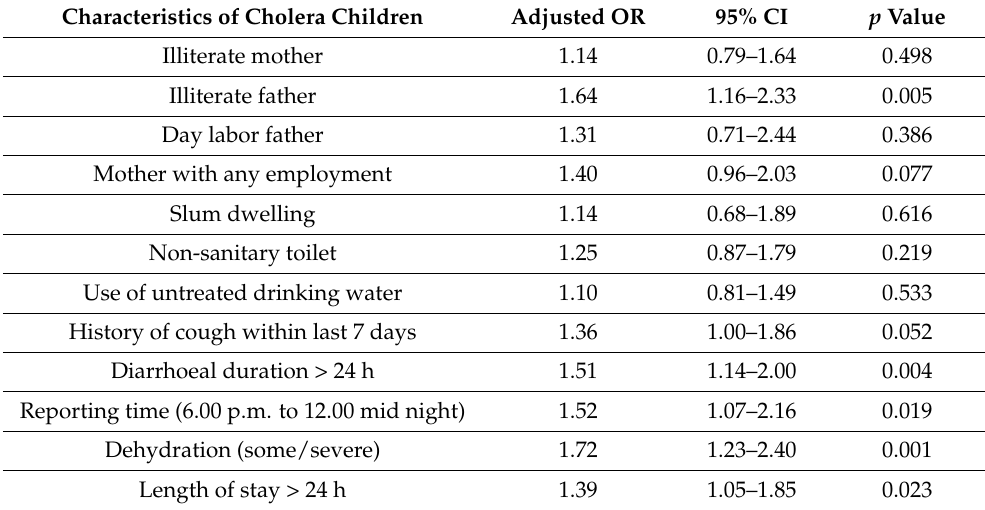
Table 2. Multivariable logistic regression analysis that showed the factors associated with cholera children with malnutrition in Bangladesh, 2001 to